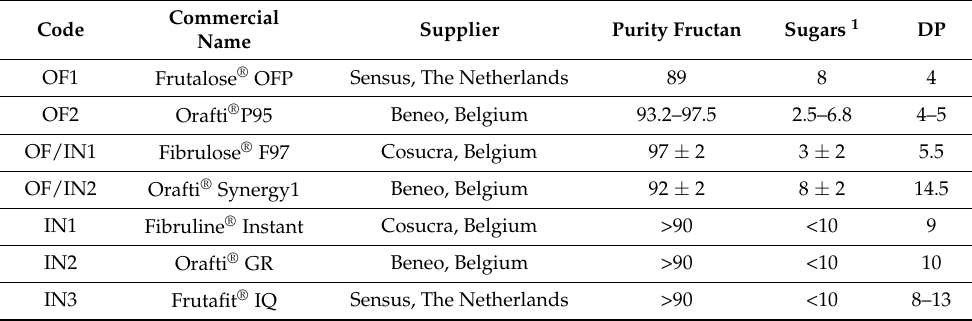
Table 1. Overview of the seven fructans tested, including the product code used in the study, the commercial name of the product, the supplier, the purity of the fructan fibers (%), the simple sugar content (%) and the average degree of polymerization (DP). OF = oligofructose; IN =